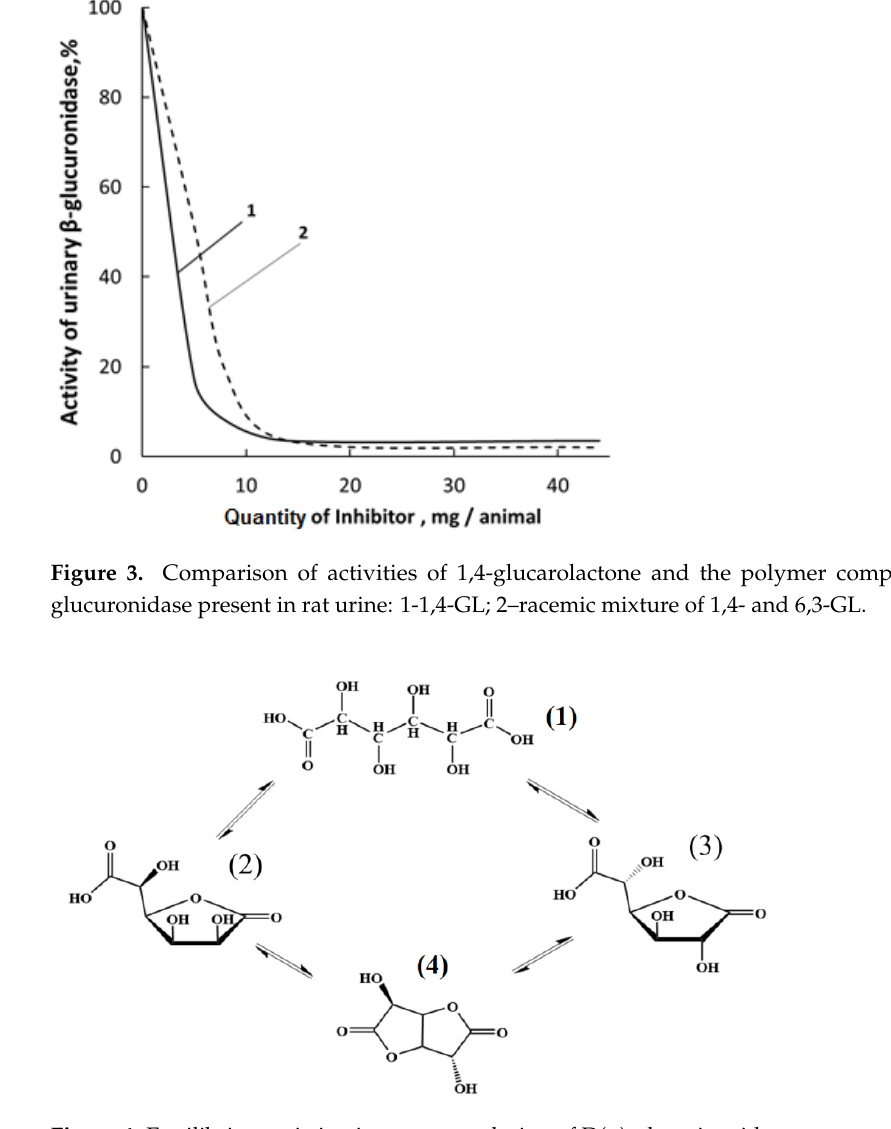
Figure 4. Equilibrium existing in aqueous solution of D(+)-glucaric acid.